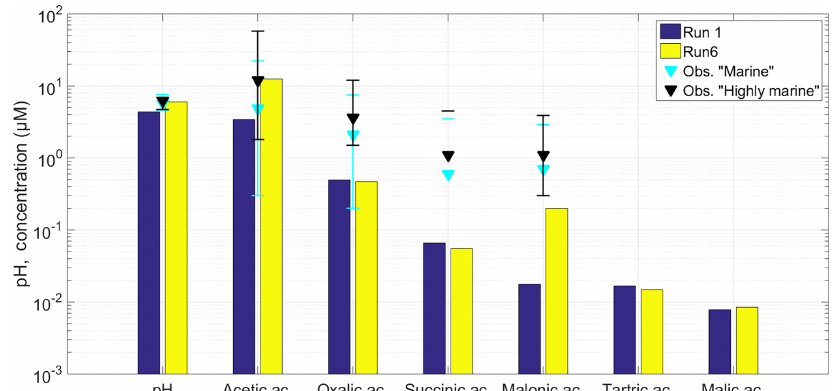
Figure 6. Averaged concentrations of some carboxylic acids calculated by the model during Run 1 (reference) and Run 6 (pH = 6). When available, the concentrations measured in marine and highly marine clouds sampled at Puy de Dôme and reported by Deguillaume et al. (2014) are shown for comparison. Markers represent the mean concentrations, while lower and upper limits of the error bars respectively show the minimum and maximum concentrations measured at this site. For succinic acid, the minimum concentration was below the detection limit of the instrument and is thus not